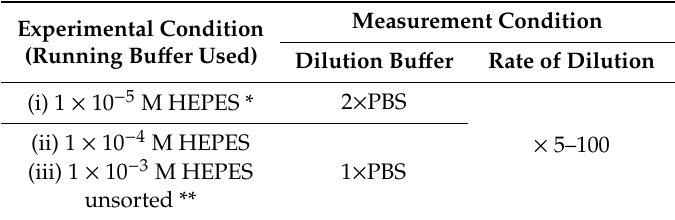
Table 1. Experimental conditions of the electrokinetic transportation of exosomes, and the size measurement